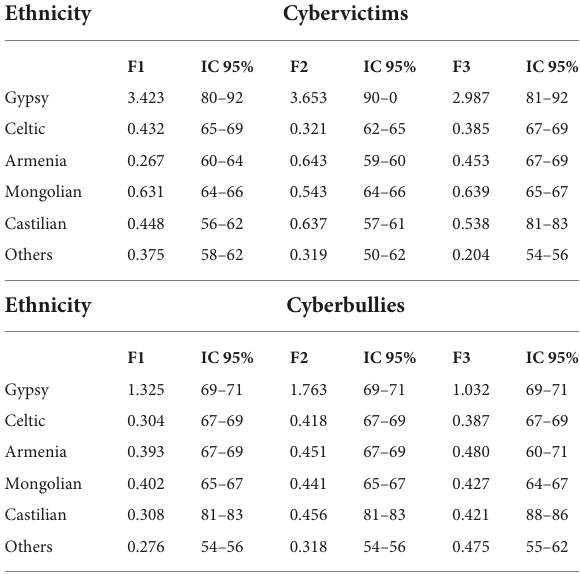
TABLE 7 Kruskal–Wallis H -test for cybervictims and cyberbullies according to